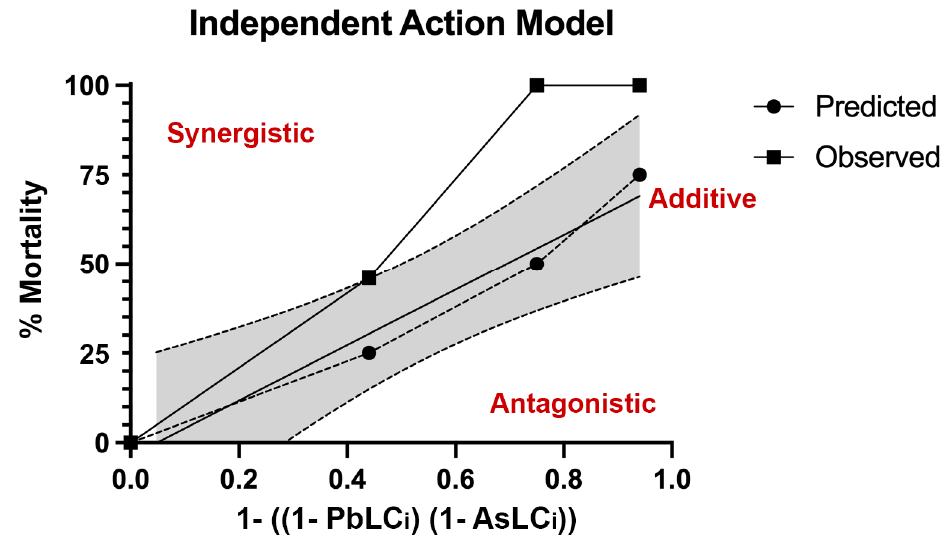
Figure 7. Observed and predicted mortality using the independent action (IA) model. Developing zebrafish were exposed to the metal mixtures from 1 to 120 h post fertilization (hpf) and mortality recorded. Results were compared to predicted mortality based on the IA model, where the predicted LC of each metal is equal. The upper deviation of the observed curve compared to the predicted curve suggests a synergistic response. N = 3 biological replicates per treatment group with 50 subsamples per biological replicate.